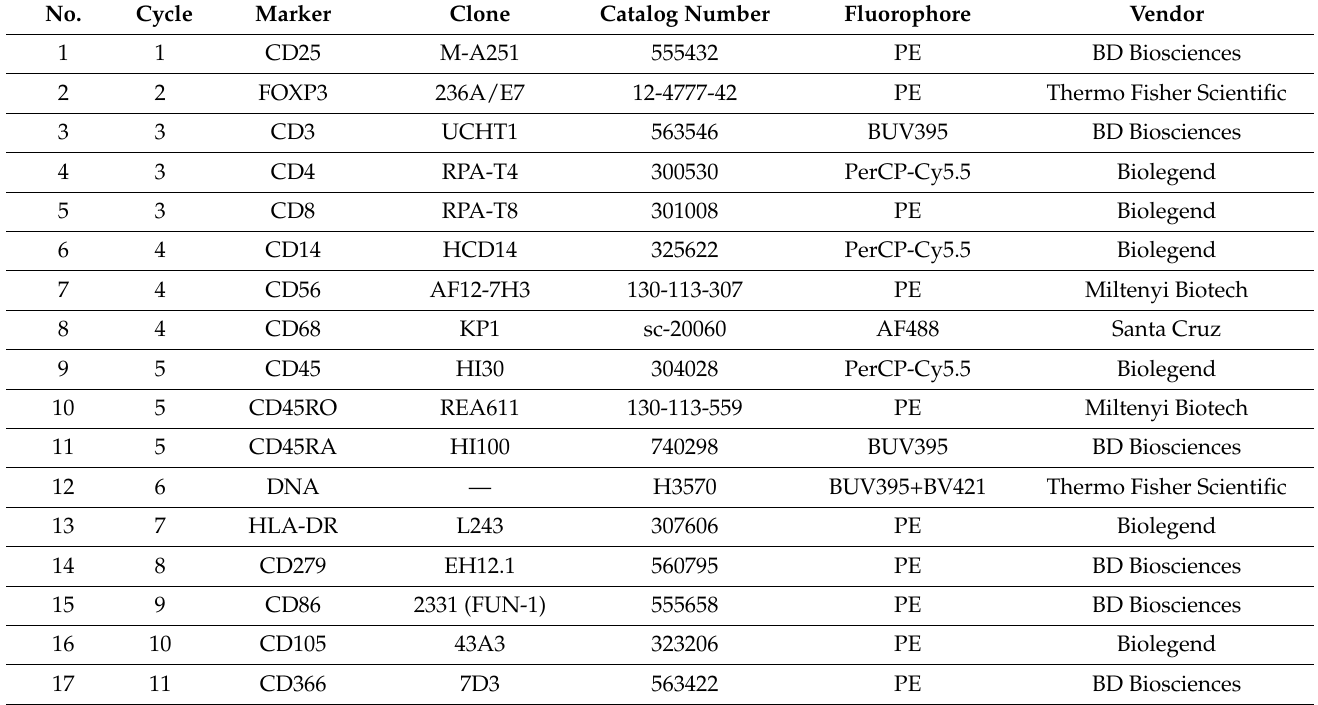
Table 2. Multiplex staining